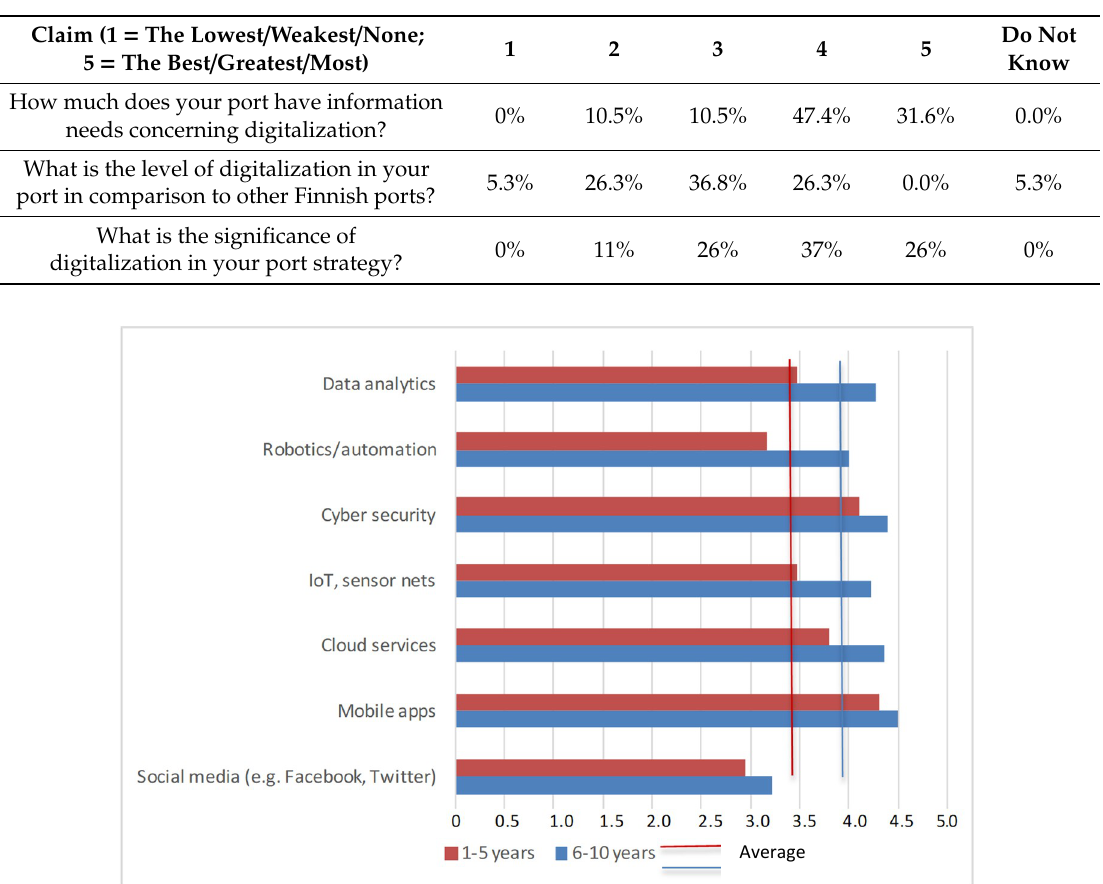
Figure 1. Port considerations of key technologies and their significance (0 = no importance; 5 = the highest importance) in two time spans (1 to 5 years) and (6 to 10 years).